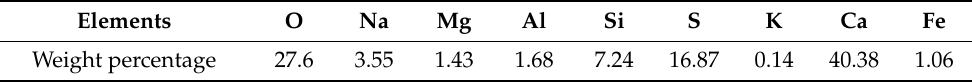
Table 7. The weight percentage of elements in concrete containing type II bacteria.